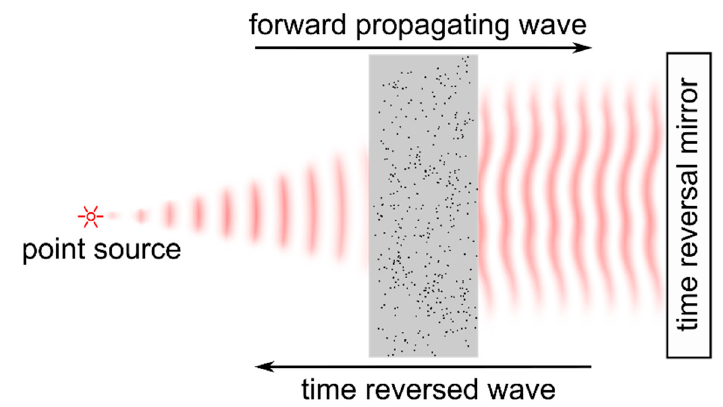
Figure 3. Principle of time reversal and phase conjugation. The field emitted from a (point) source is recorded after propagation through a scattering sample. Applying the time-reversed or the phase-conjugated field to the backside of the sample corresponds to a reversal of propagation direction and recovers the shape of the source field at the front. Image from [8], with permission.